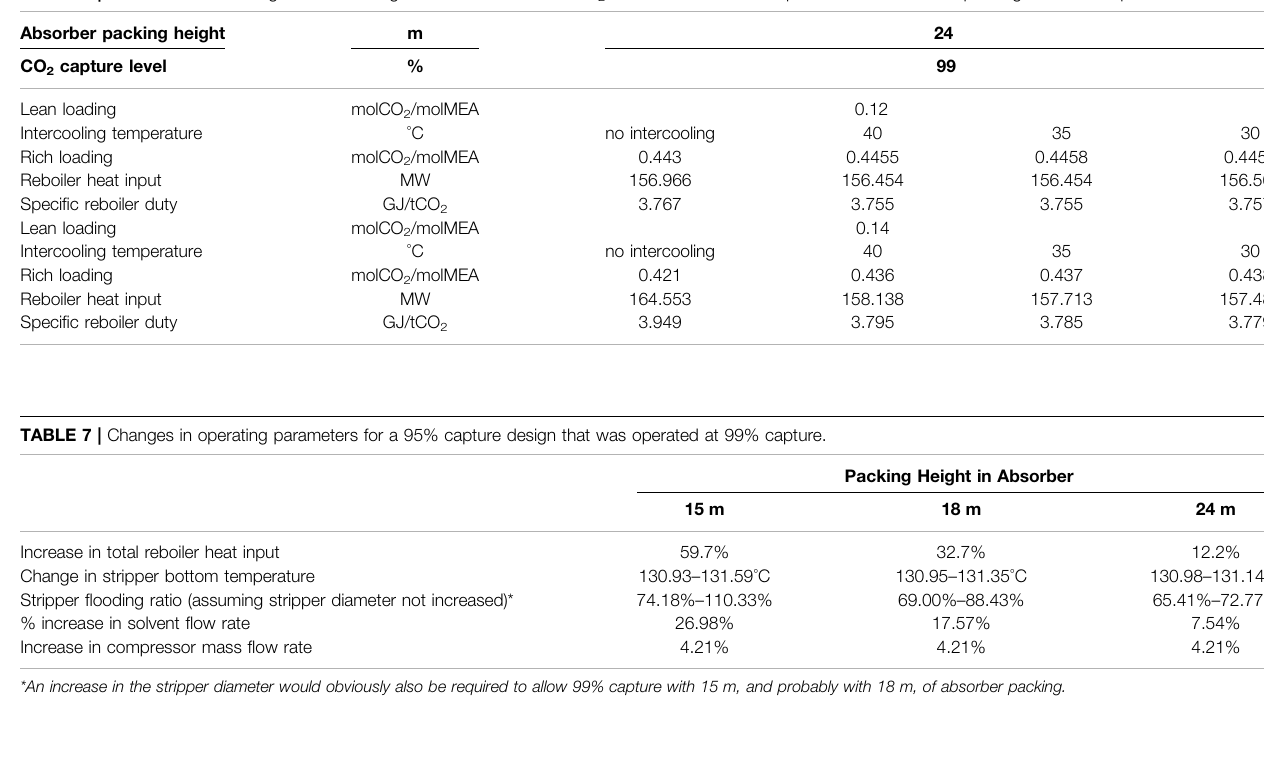
TABLE 6 | Results for intercooling for lean loadings of 0.12 and 0.14 molCO 2 /molMEA at various temperatures with 24 m of packing and 99% capture.